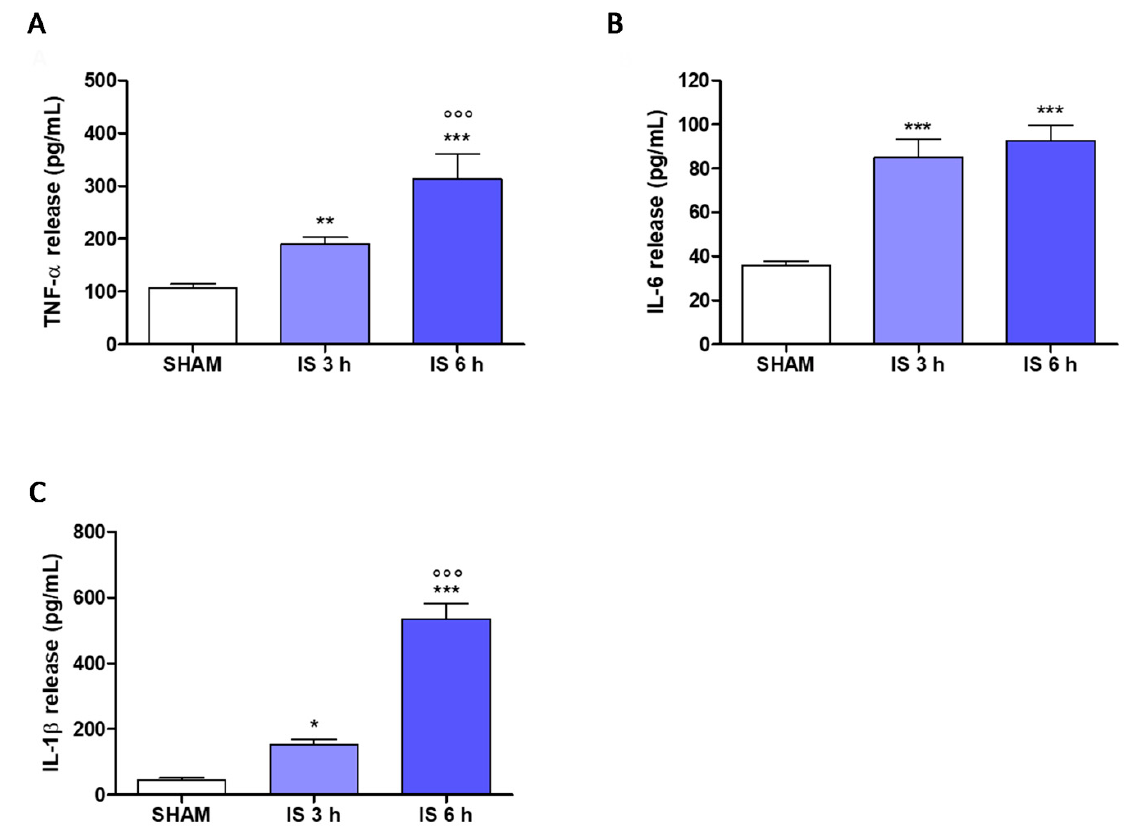
Figure 6. Effect of Indoxyl Sulfate (IS; 800 mg/kg; i.p.) on tumor necrosis factor- α (TNF- α ; A ), interleukin-6 (IL-6; B ) and interleukin-1 β (IL-1 β ; C ) levels in mice serum after 3 h or 6 h of treatment, evaluated by Enzyme-Linked Immuno Sorbent Assay (ELISA). Values are expressed as pg/mL of cytokines release. ***, ** and * denote respectively p < 0.001, p < 0.01 and p < 0.05 vs SHAM; °°° denotes p < 0.001 vs IS 3 h.